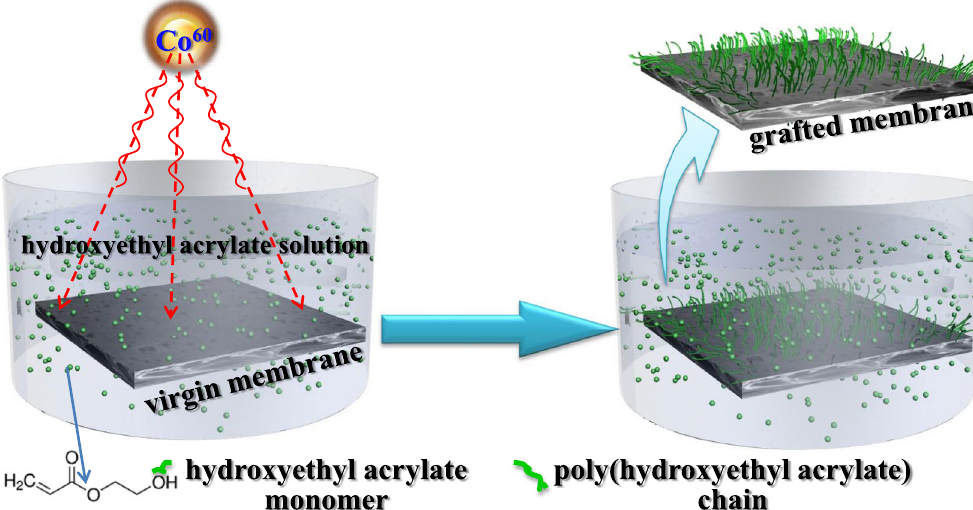
Figure 1. The schematic illustration of the grafting process.